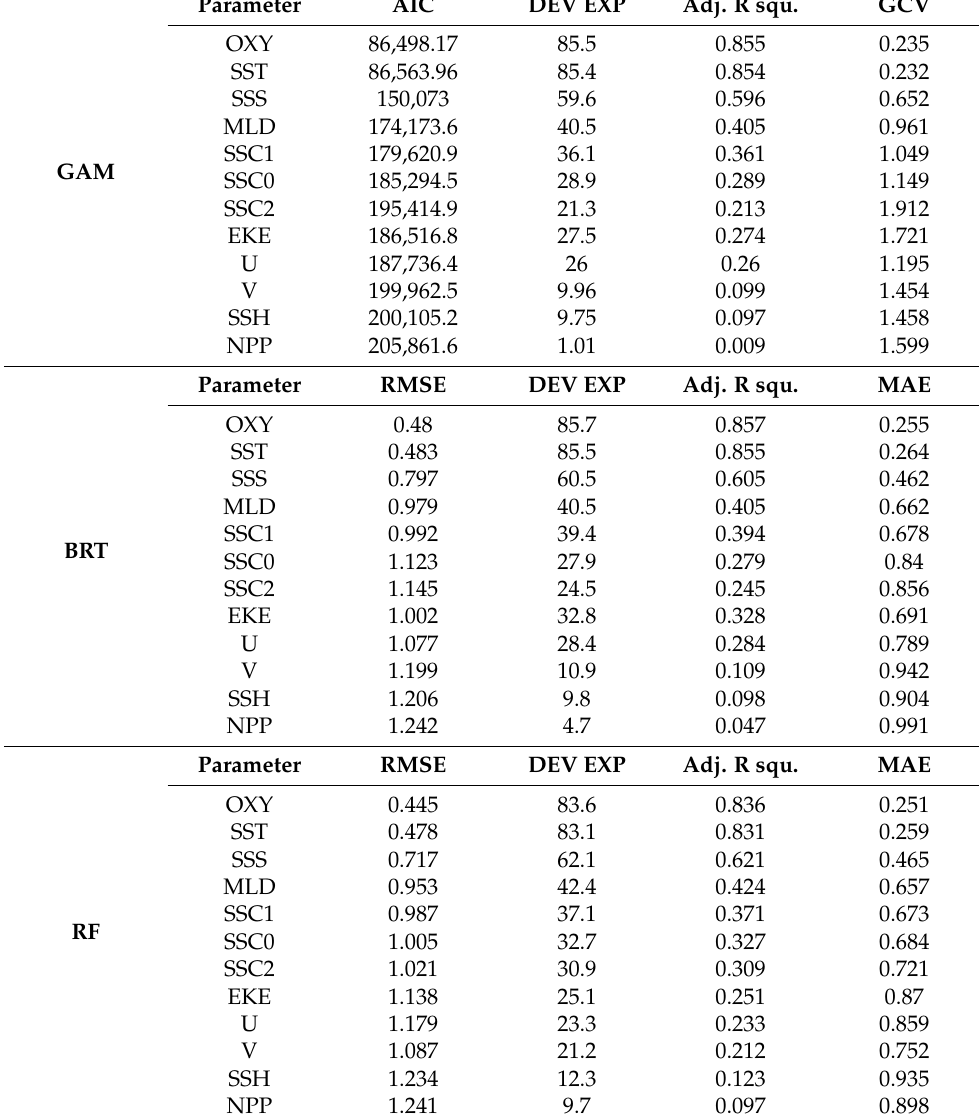
Table 3. Environment parameters selected using GAM, BRT, and RF for immature albacore tuna model construction.